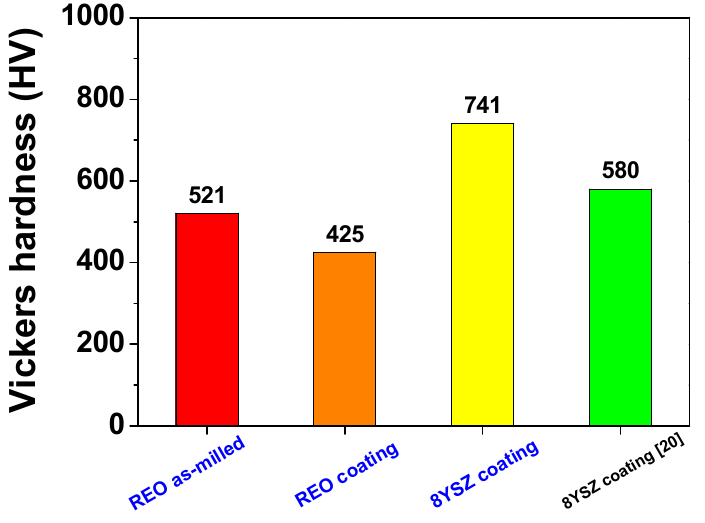
Figure 6. Comparison of Vickers hardness values of as-milled REO, REO coating, and 8YSZ coating.